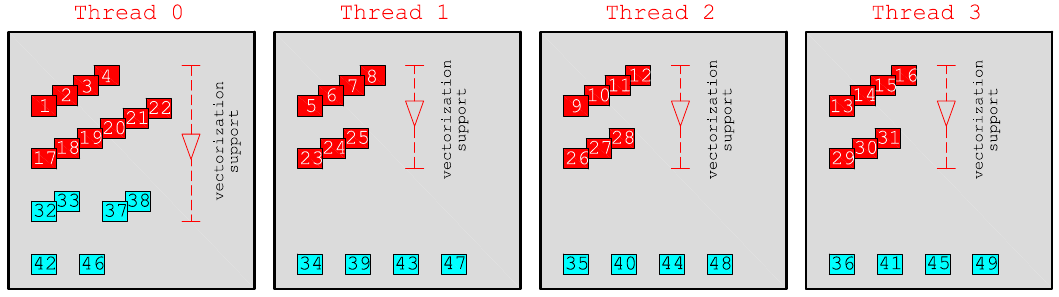
Figure 4. Illustration of load distribution using static load balancing with vectorization support for the edge-driven level based on Figure